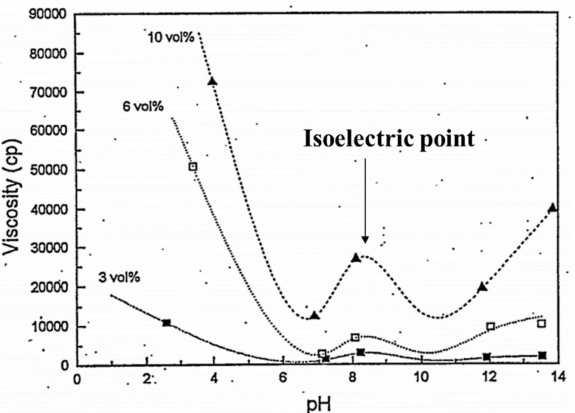
Figure 9. General evolutions of the viscosity of boehmite sols versus pH for different loadings of solid [32].